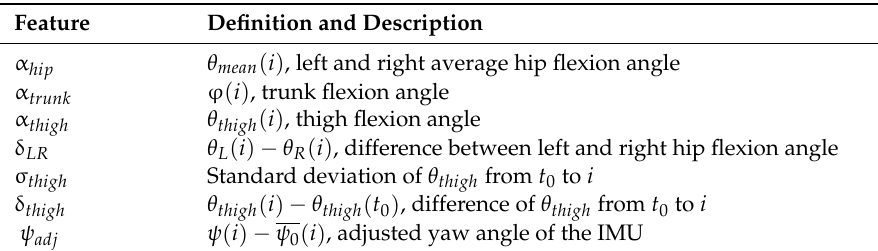
Table 1. List of candidate features.